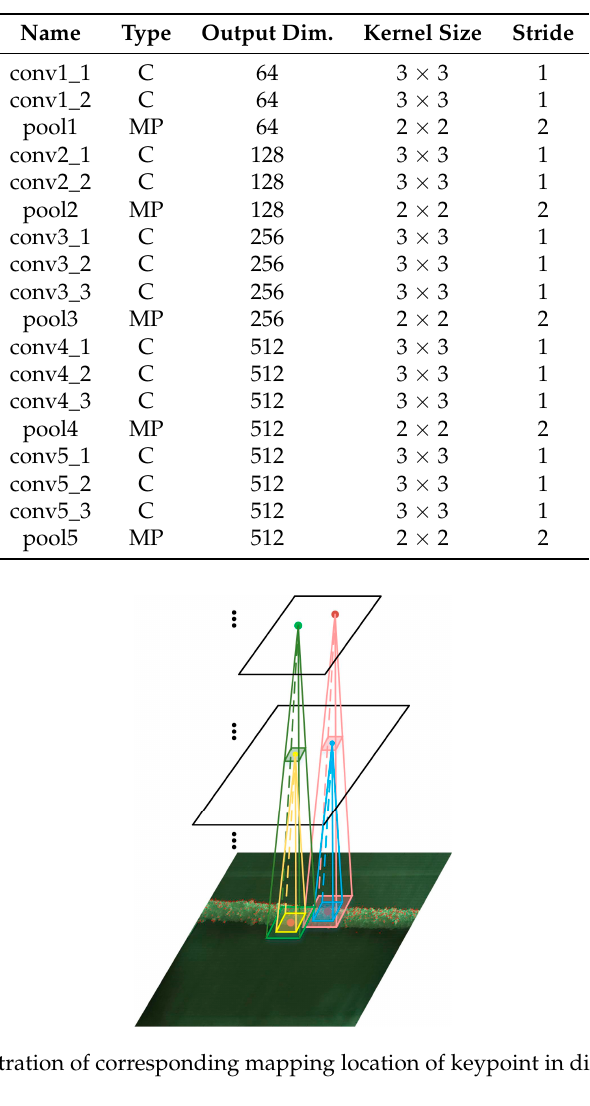
Table 1. Feature network architecture of fully convolutional network based on VGG 16-layer net